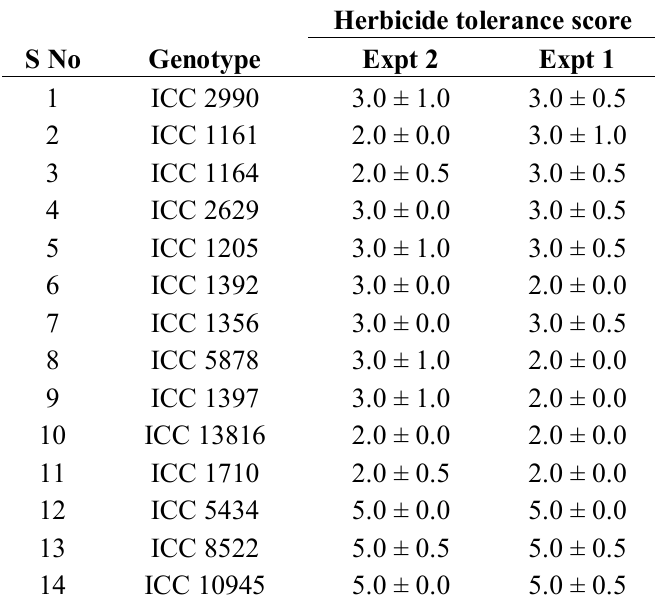
Table 2. Comparison of herbicide tolerance scores from the two experiments conducted at IIPR, Kanpur (Mean score ± SE on a scale from 1 to 5, where 1 = highly resistant and 5 = highly